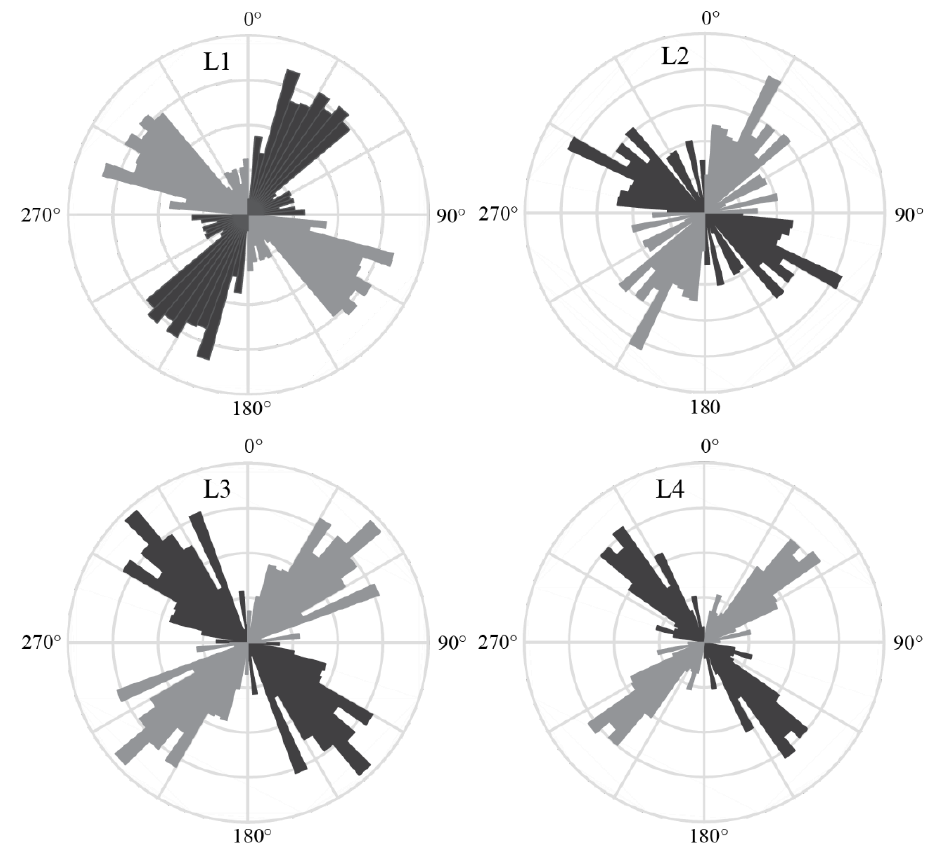
Figure 5. Statistical results of the strike analysis of profiles L1, L2, L3, and L4 in a frequency range of 100~0.01 Hz. Black wedges indicate the preferred strike